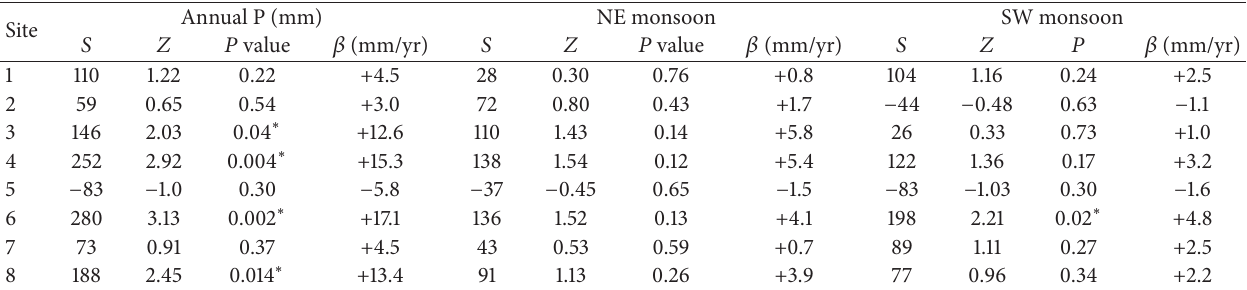
Table 5: The results of the MK and TSS methods for annual and seasonal precipitation in the Langat River Basin. Site